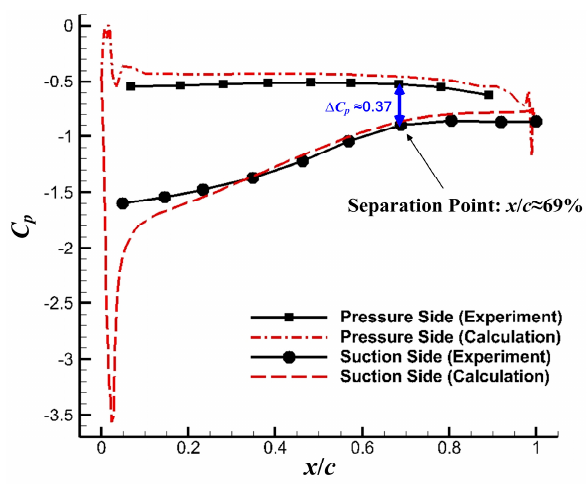
Figure 21. Static pressure distribution on the cascade blade surface.